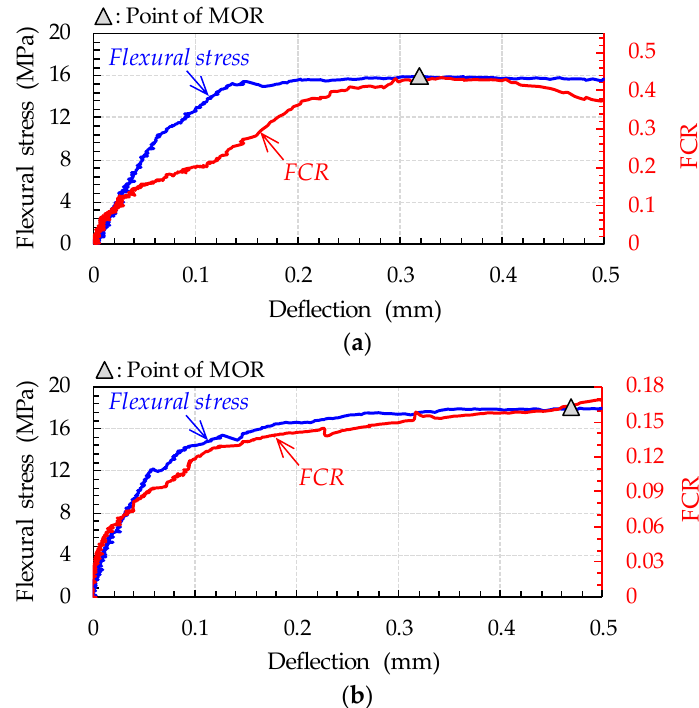
Figure 14. Comparative flexural stress–deflection and FCR–deflection curves for UHPFRC with: ( a ) 0.1% CNTs; and ( b ) 0.3% CNTs.